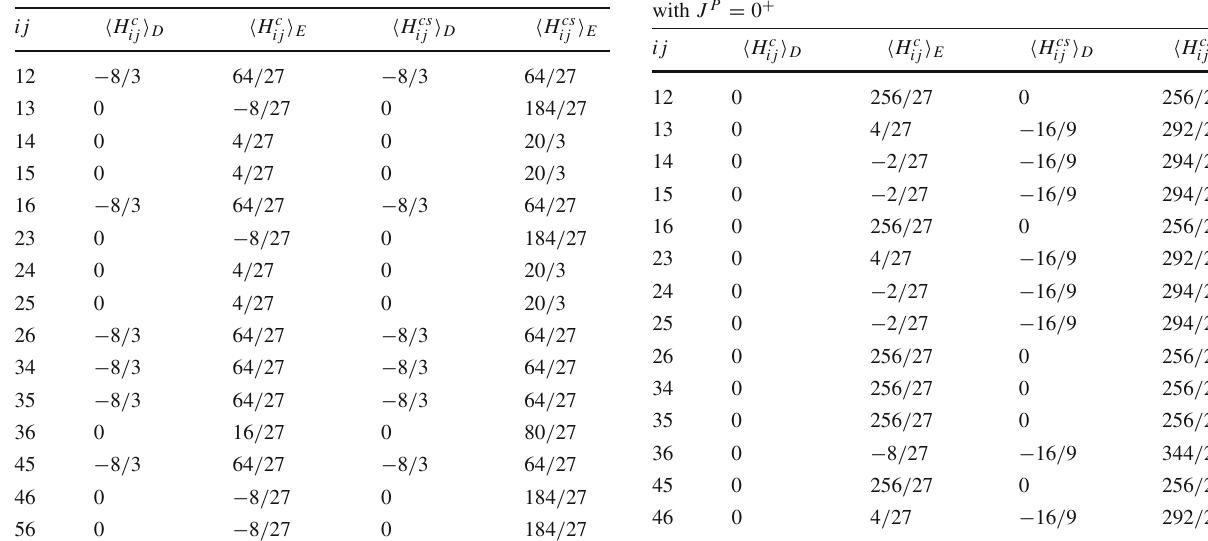
Table 10 The matrix elements in spin-flavor-color-isospin spaces of the color-singlet channel for the Ω ccb Ω bbc system with J P = 0 +